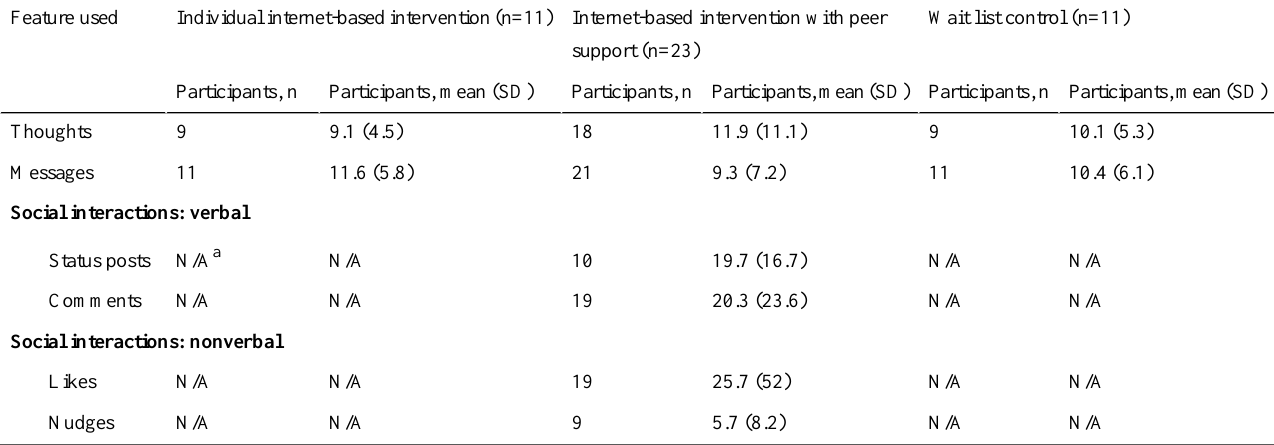
Table 2. Engagement metrics for the skills and peer support components of the MoodTech intervention. (n=23)Individual internet-based intervention (n=11)Feature used